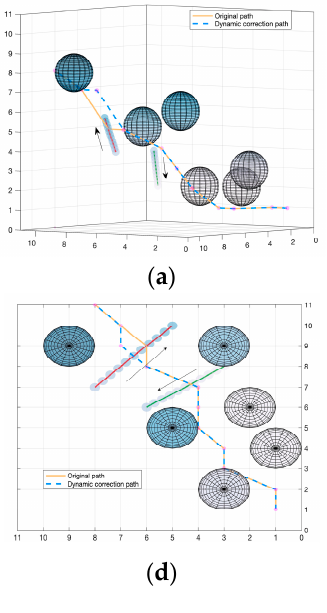
Figure 15. Path Optimization Algorithm Results.